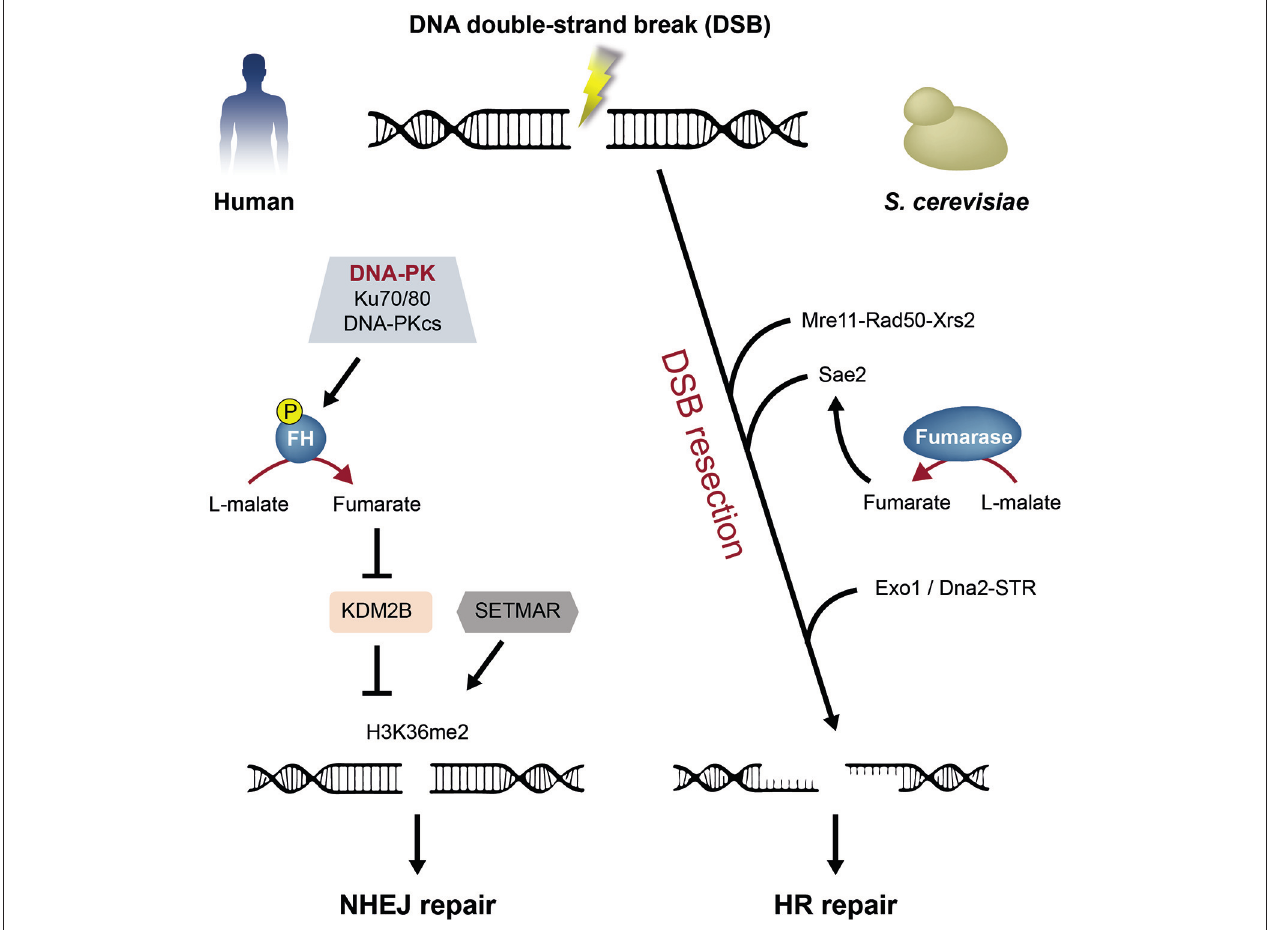
FIGURE 3 | Fumarase functions in the human and yeast DNA damage response (DDR) to double-strand breaks (DSBs). Two DSB repair pathways in human and yeast are non-homologous end joining (NHEJ) and homologous recombination (HR). Left panel: Upon DSB formation in human cells, fumarase (FH) is phosphorylated on Thr236 by the DNA-dependent protein kinase (DNA-PK) complex. This modification induces the recruitment of fumarase to the DSB and local generation of fumarate. Fumarate inhibits the lysine demethylase 2B (KDM2B), thereby facilitating the dimethylation of histone H3 on lysine 36 (H3K36me2) by the SET domain and mariner transposase fusion protein (SETMAR). This leads to the repair of the break by the NHEJ pathway. Right panel: The repair of a DSB by the HR pathway, requires that the DNA flanking the DSB undergoes resection. In yeast, the resection process is orchestrated by the Mre11-Rad50-Xrs2 complex, Sae2, Exo1, and the Dna2-STR complex. The yeast cytosolic fumarase and the metabolite fumarate affect the DSB resection process, by regulating the protein level of the resection factor